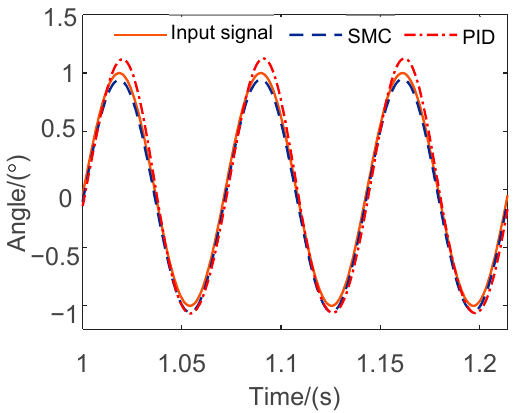
Figure 9. Dynamic response of the controller under sinusoidal excitation at 14 Hz and 1°.